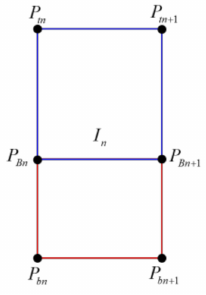
Figure 10. Splitting wall and floor images in I n . The upper region (blue line) of the divided image is mapped to the wall, while the lower region (red line) is mapped to the blank